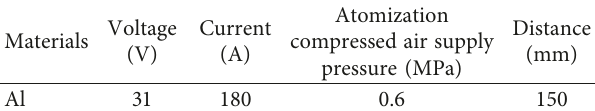
Table 1: Arc-sprayed